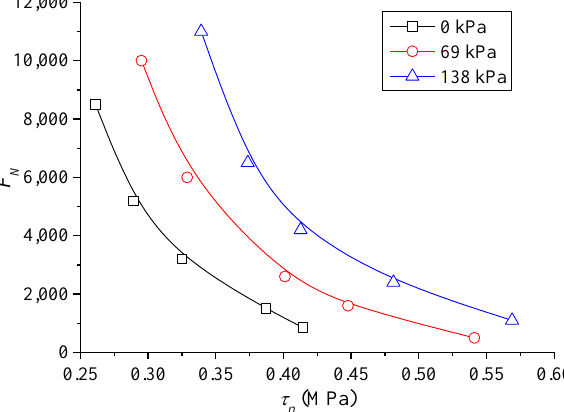
Figure 12. Curve chart of F N with shear stress level.